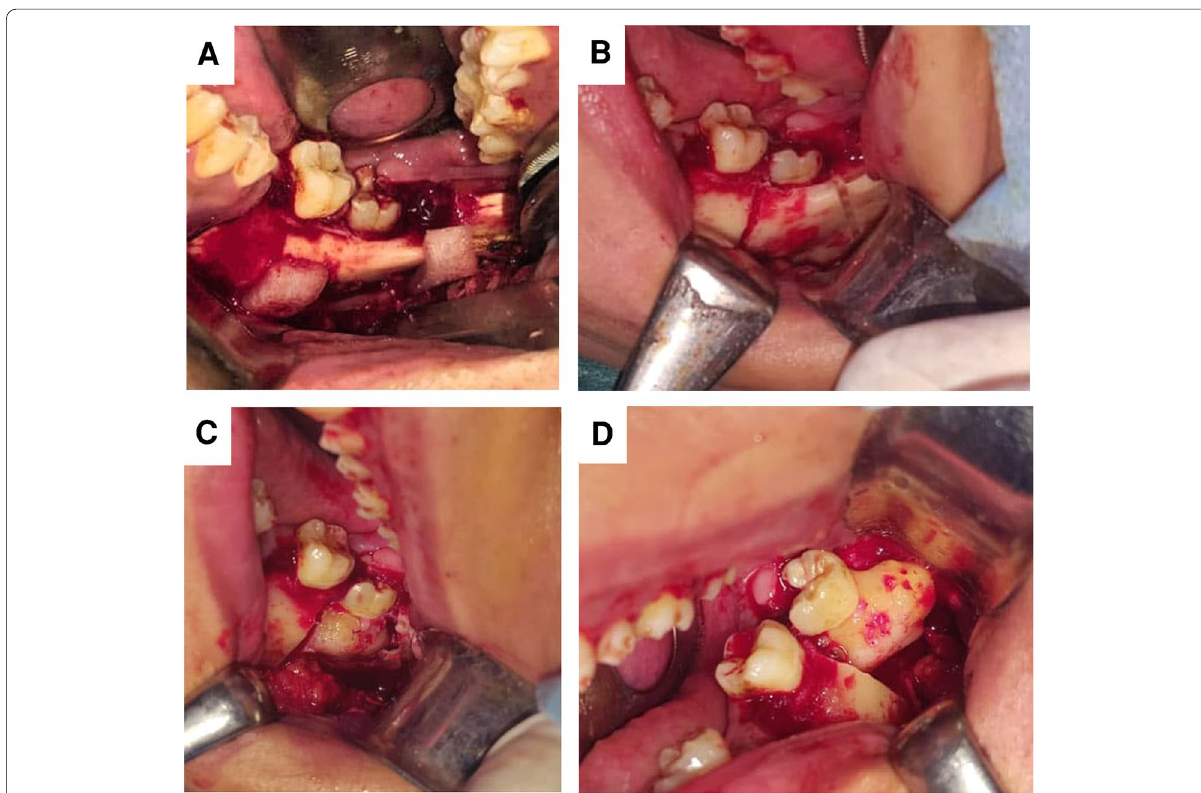
Fig. 4 Surgical procedures. A The surgical guide fixed in place. B Osteotomy performed according to the preoperative plane. C Buccal cortical plate removed from position exposing the intra-bony calcific mass. D The exposed mass passively removed